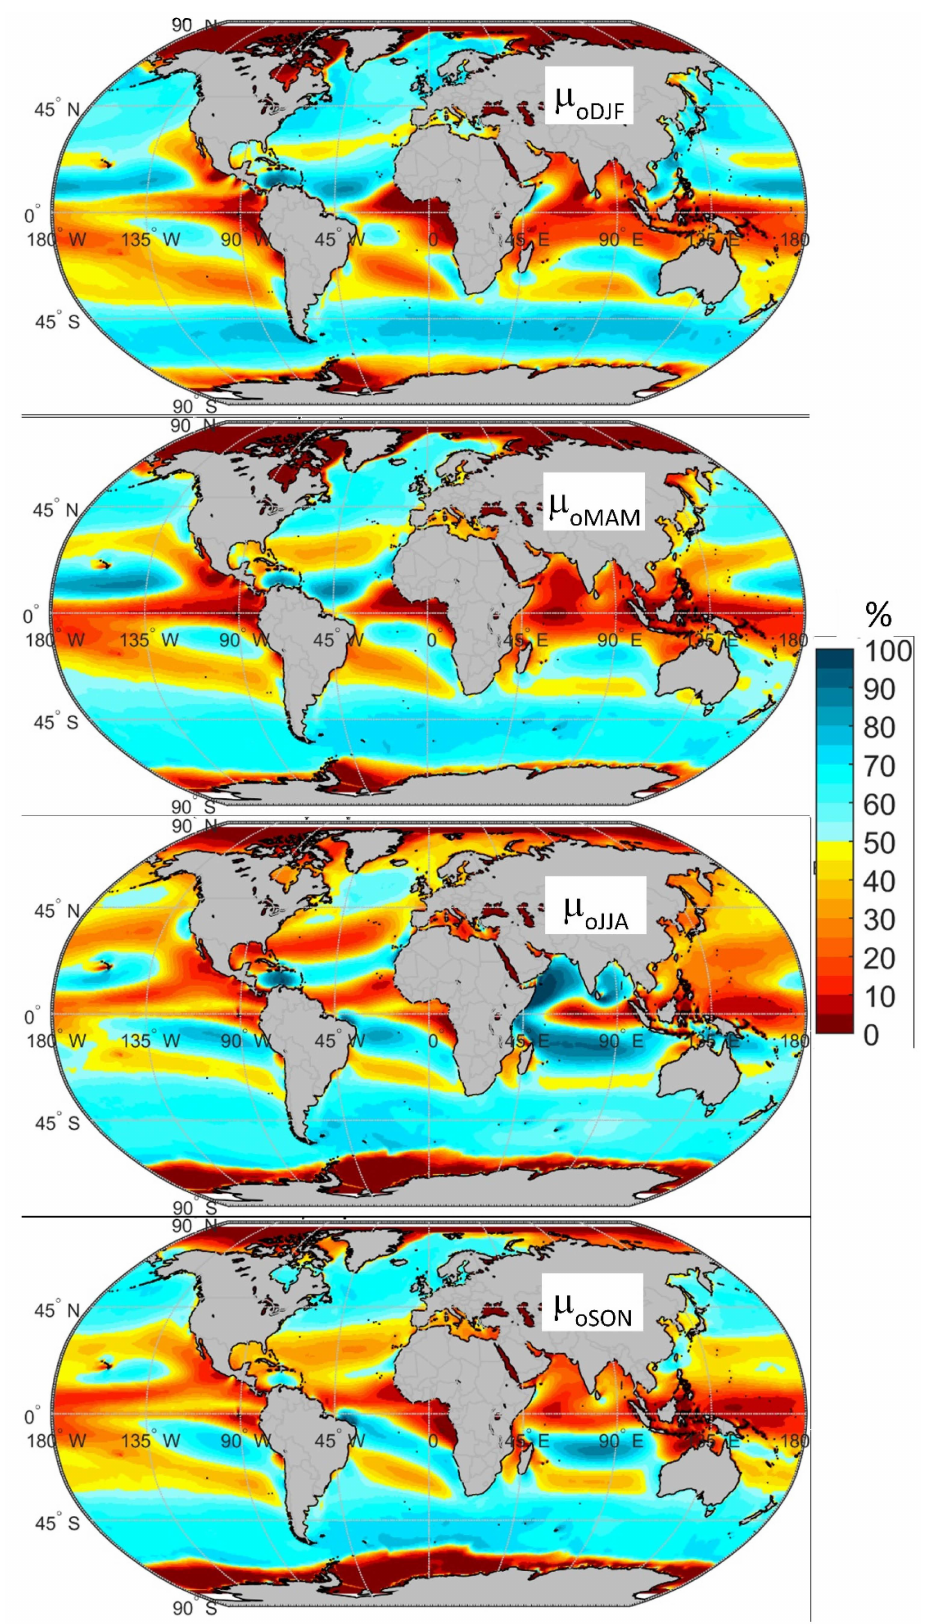
Figure 10. Global distribution of the seasonal mean